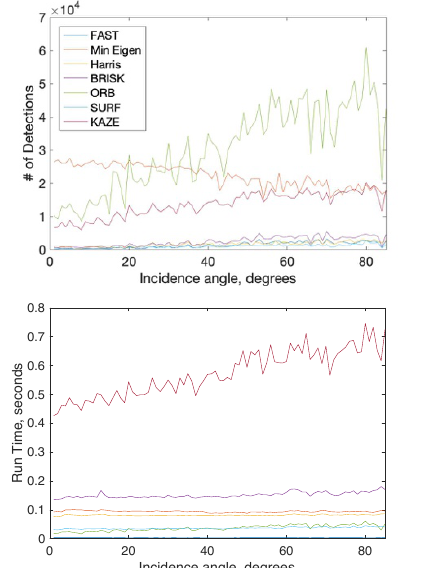
Figure 2 . Number of detections (top) and run time (bottom) vs. solar incidence angle.